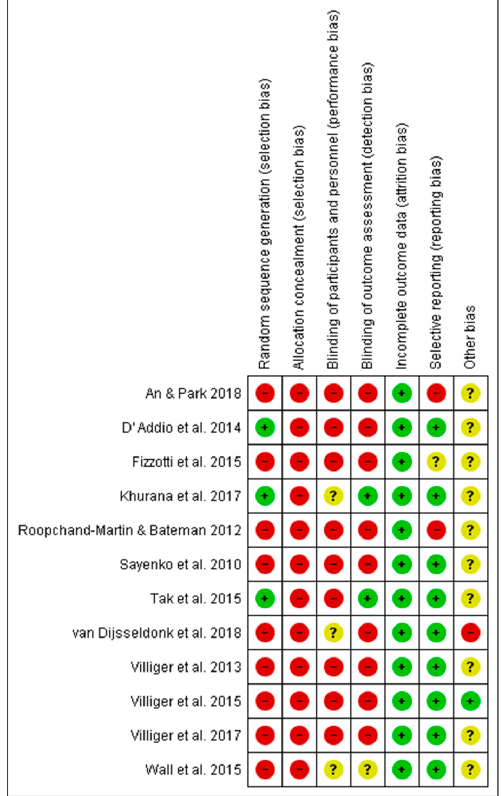
Figure 2. Risk of bias of the studies included in the systematic review.